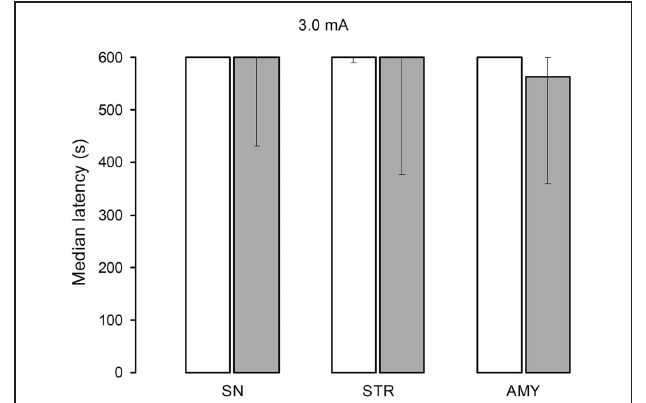
FIGURE 4 | Median retention scores (with interquartile range) of groups of rats trained in one-trial inhibitory avoidance and injected with either isotonic saline solution (open bars) or 2% lidocaine (filled bars) into the nigra (SN), striatum (STR), or amygdala (AMY). Lidocaine was totally ineffective in altering memory when training was conducted with 3.0mA, regardless of infusion site.